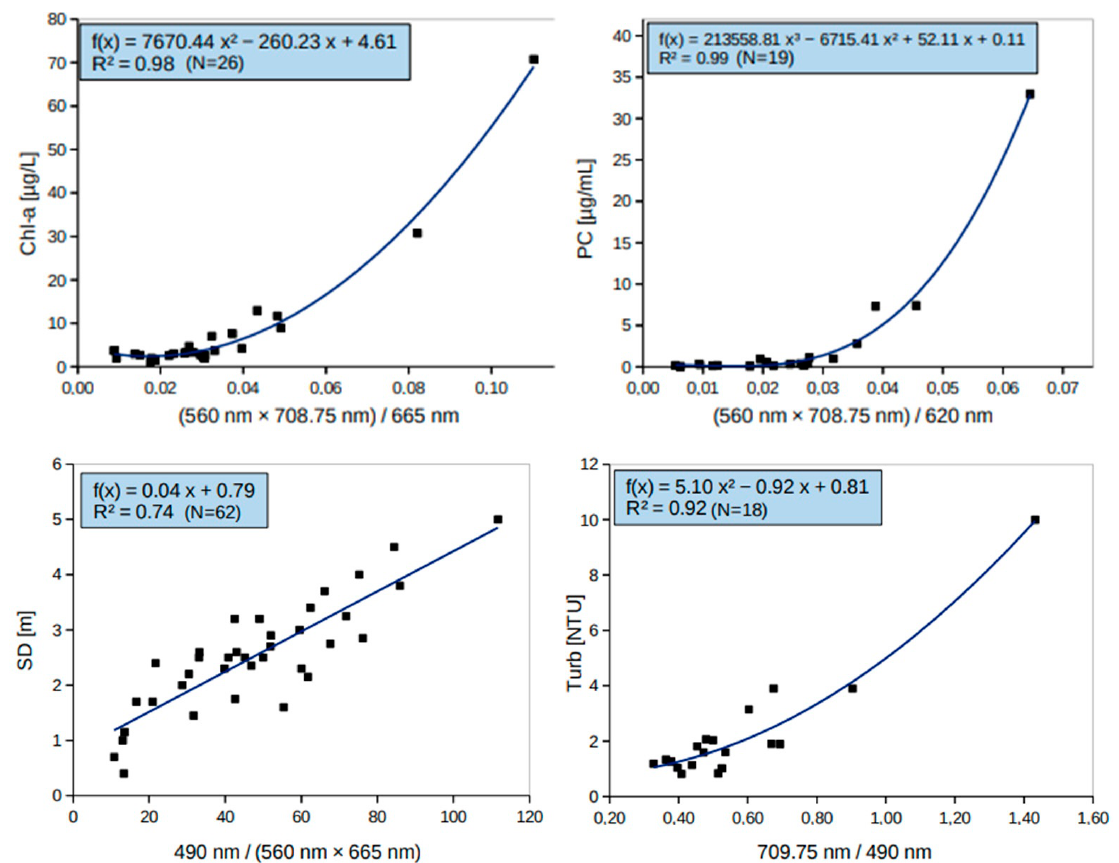
Figure 4. Scatter plot between the water quality parameters and the combination of OLCI band reflectances (Chl-a and PC on the top panel; SD and water turbidity on the bottom panel).